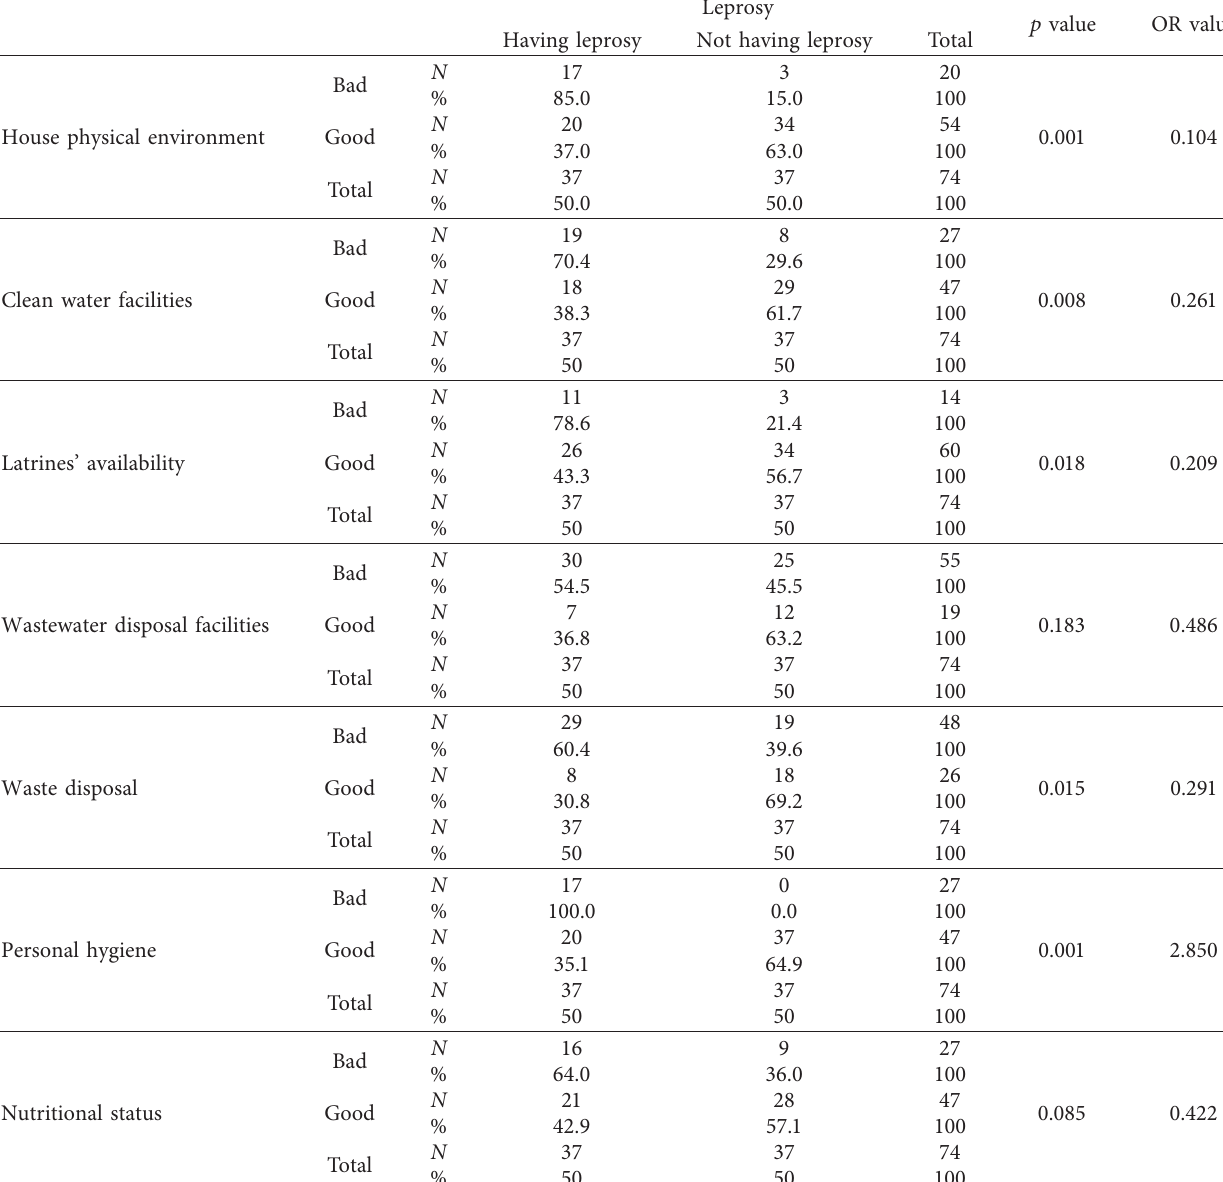
Table 2: Relationship between household hygiene and sanitation with leprosy.